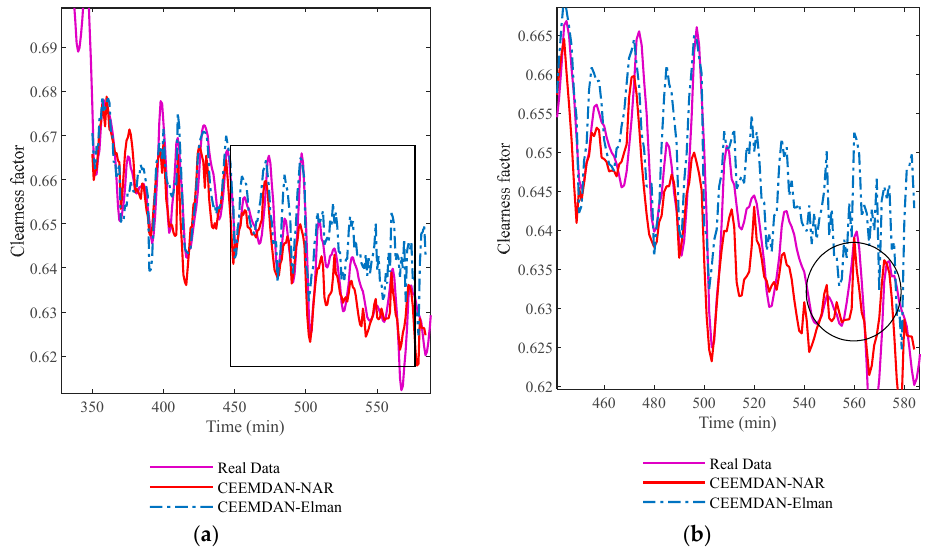
Figure 11. Using CEEMDAN to predict at different starting points. 350 min ( a ) and partial enlarged figure ( b ).